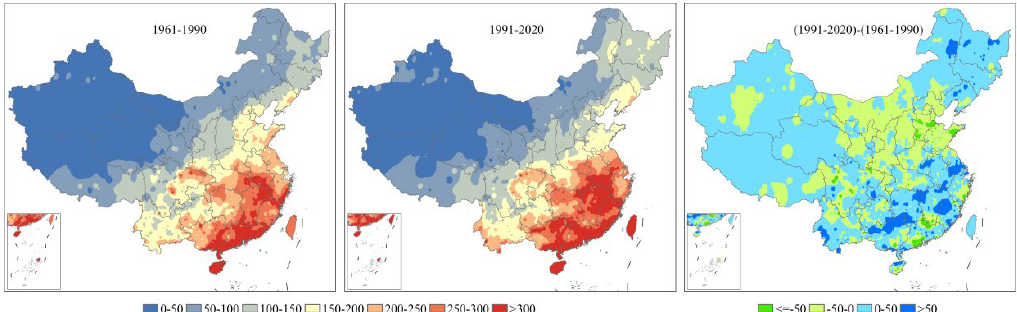
Figure 8. Variation in precipitation during the potential agricultural growing season for the indicated time periods.